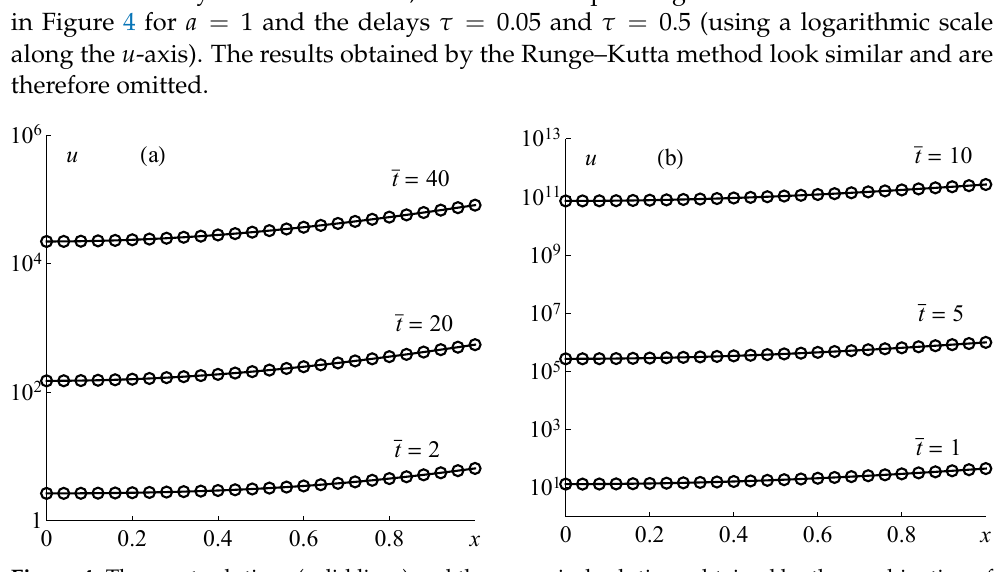
Figure 4. The exact solutions (solid lines) and the numerical solutions obtained by the combination of the method of lines and the BDF method (circles) of test problem 2 for a = 1 and N = 100 at different times ¯ t = t / τ for two delays: ( a ) τ = 0.05 and ( b ) τ = 0.5. The relative errors of the numerical solutions obtained by the second-order implicit Runge–Kutta and BDF methods are presented in Table 2. Table 2. The relative errors of the numerical solutions of test problem 2 for a = 1 and three different delays τ